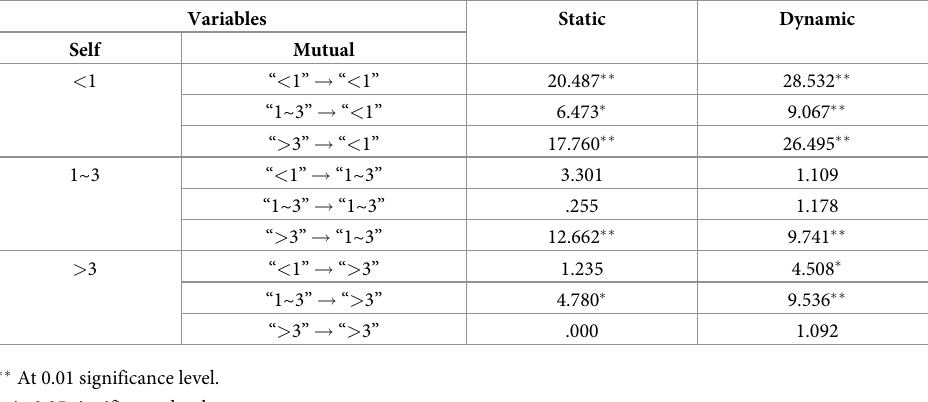
Table 8. Differences between drivers’ self-assessment and